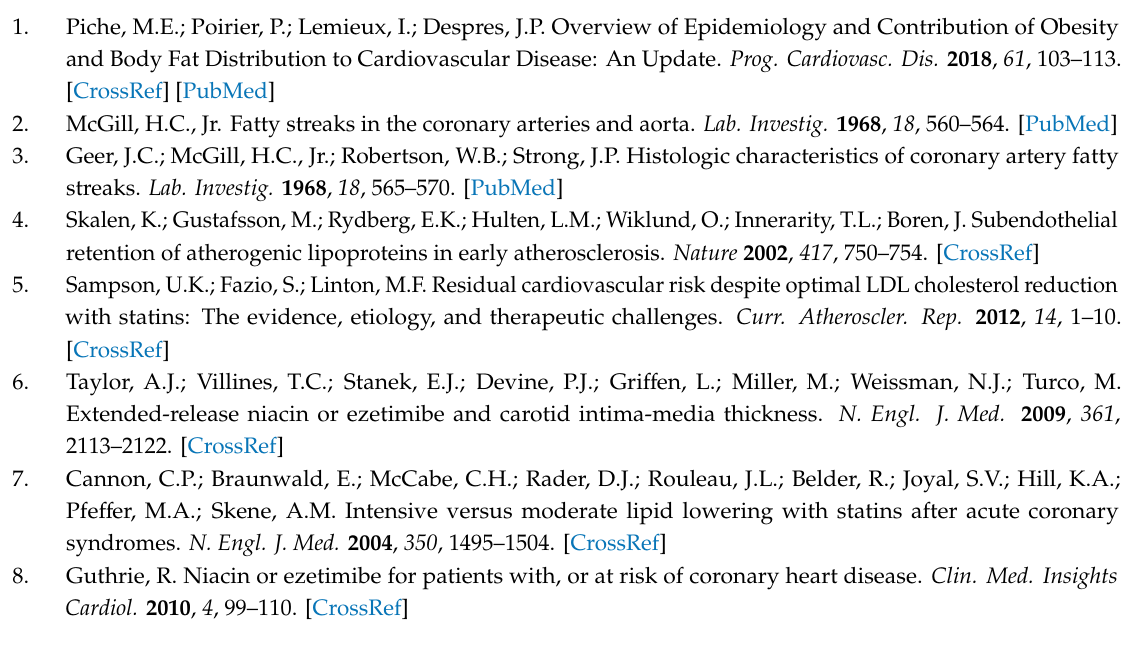
of atherosclerosis, Figure S2: Analysis of atherosclerosis in proximal aortas of ApoE-deficient mice treated with di ff erent doses of NAM, Figure S3: Correlations between the levels of oxidized LDL (OxLDL) and cytokines in the thoracoabdominal aorta with atherosclerotic lesions in the proximal aorta of ApoE-deficient mice, Figure S4: E ff ect of NAM on the mRNA expression of molecular targets involved in cholesterol transport in the thoracoabdominal aorta of ApoE-deficient mice and in cultured macrophages, Figure S5: Negative controls for immunohistochemical staining and area fraction calculation with ImageJ software, Table S1: Transitions used in QqQ shown by di ff erent metabolites, Table S2: List of specific Taqman probes used for gene expression analysis, Table S3: List of primers sequences used for gene expression analysis by SYBR green, Table S4: Characteristics of primers used gene expression analysis by SYBR green, Supplementary